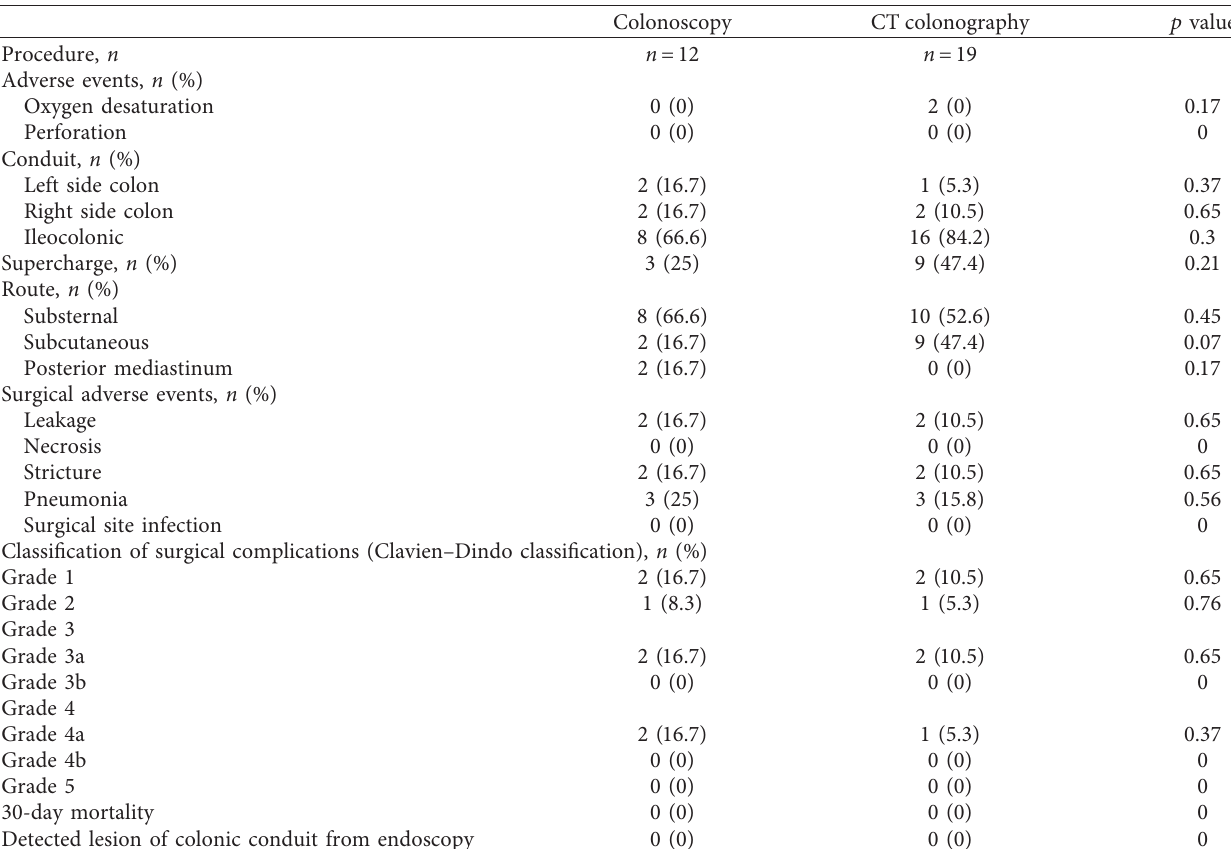
Table 3: Procedures and outcomes of colonic